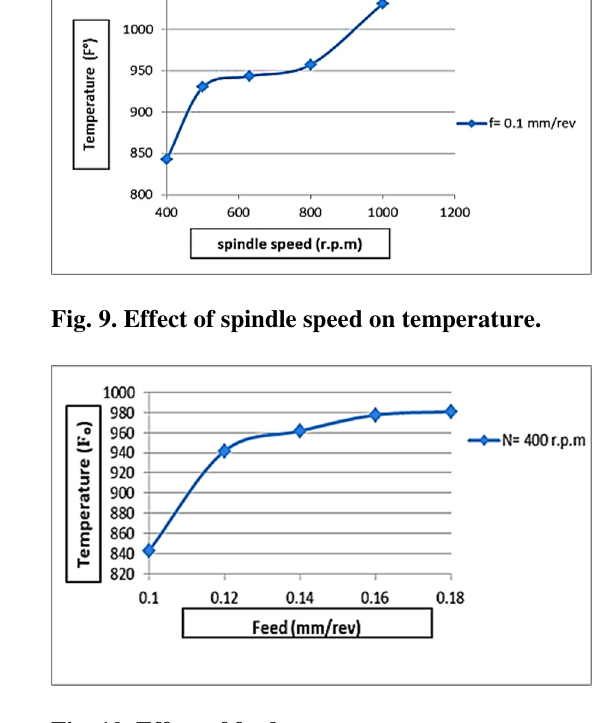
Fig. 10. Effect of feed on